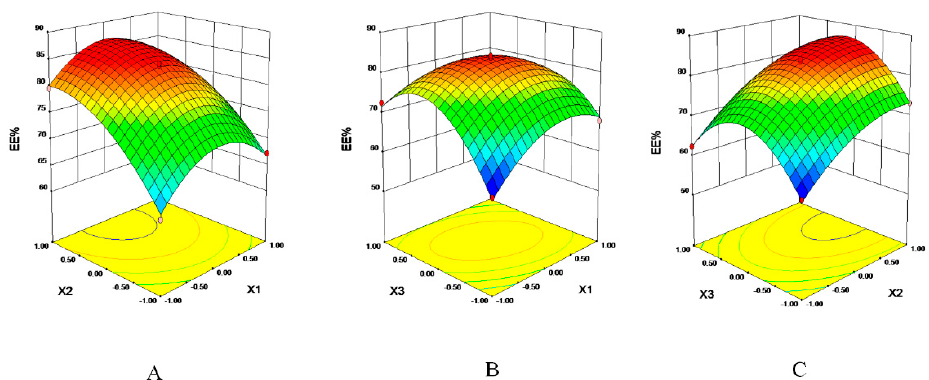
Figure 1. Response surfaces and contours. ( A ) Interaction of X1 and X2, ( B ) Interaction of X1 and X3 , ( C ) Interaction of X2 and